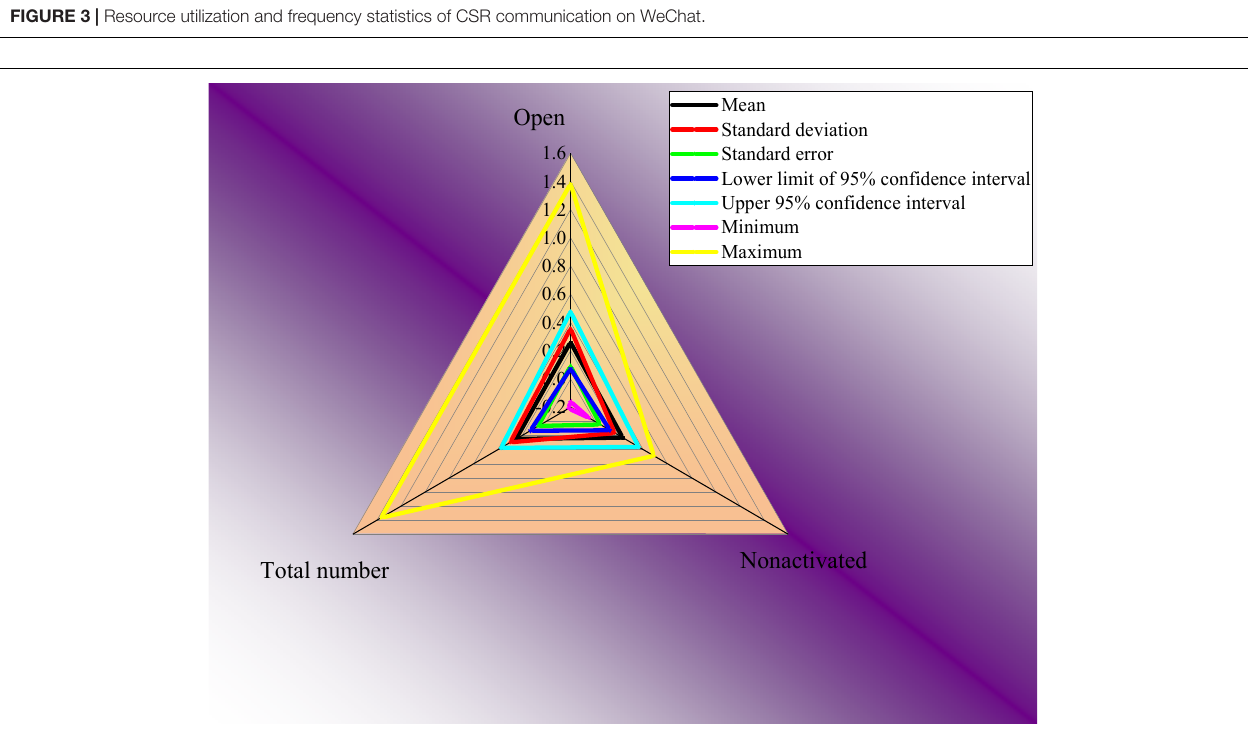
FIGURE 3 | Resource utilization and frequency statistics of CSR communication on WeChat.